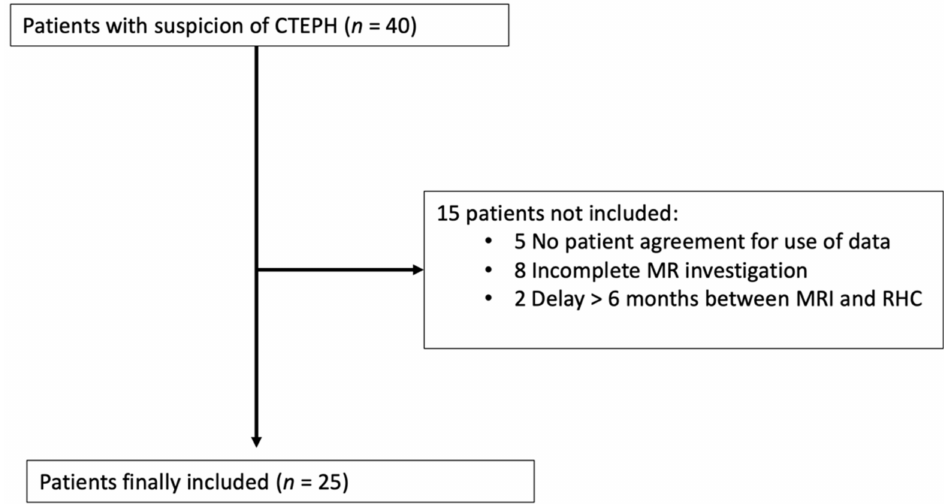
Figure 1. Flow chart of the